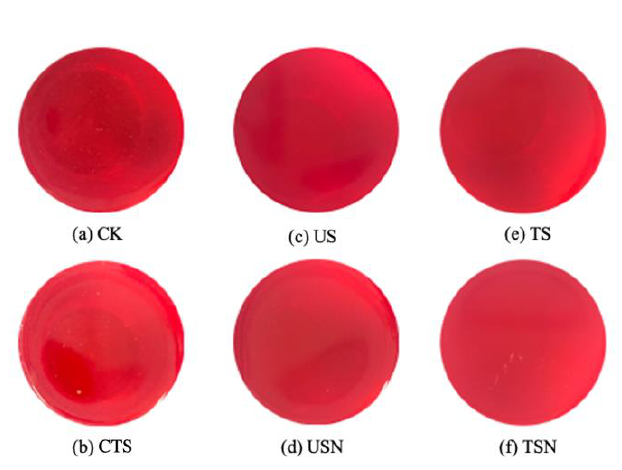
Figure 1. Pictures of grape juice after different sterilization treatments. ( a ) control group (CK), ( b ) conventional thermal sterilization (CTS), ( c ) ultrasound (US), ( d ) ultrasound combined with nisin (USN), ( e ) thermosonication (TS), ( f ) TS combined with nisin (TSN).